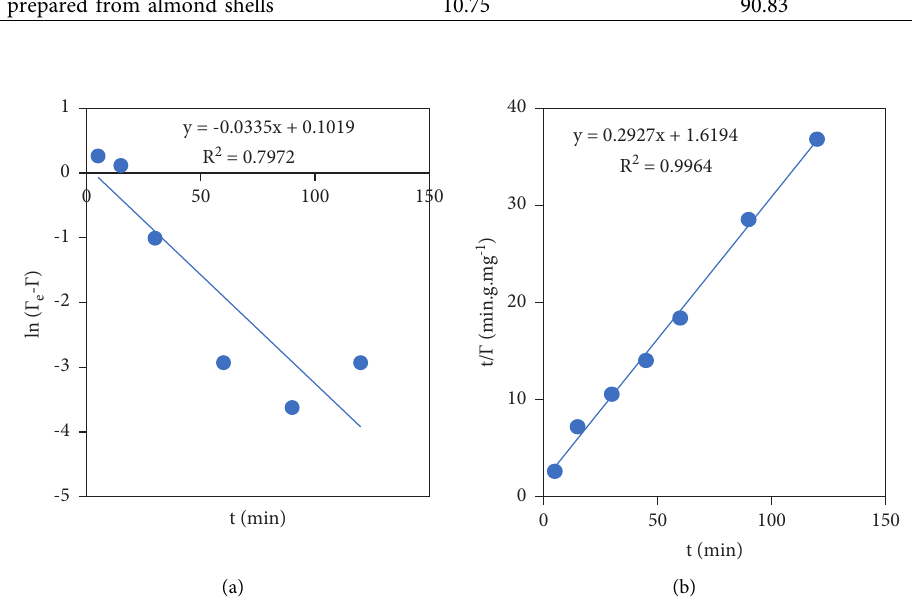
2 O 3 particles following (a) pseudo-first and (b) pseudo-second at